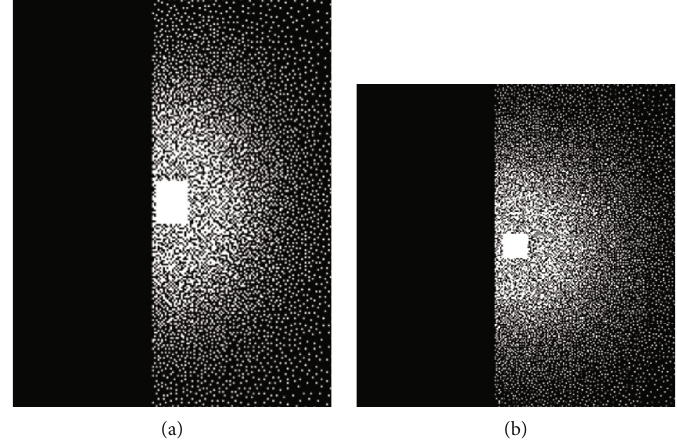
Figure 2: The sampling patterns for 8-coil and single coil